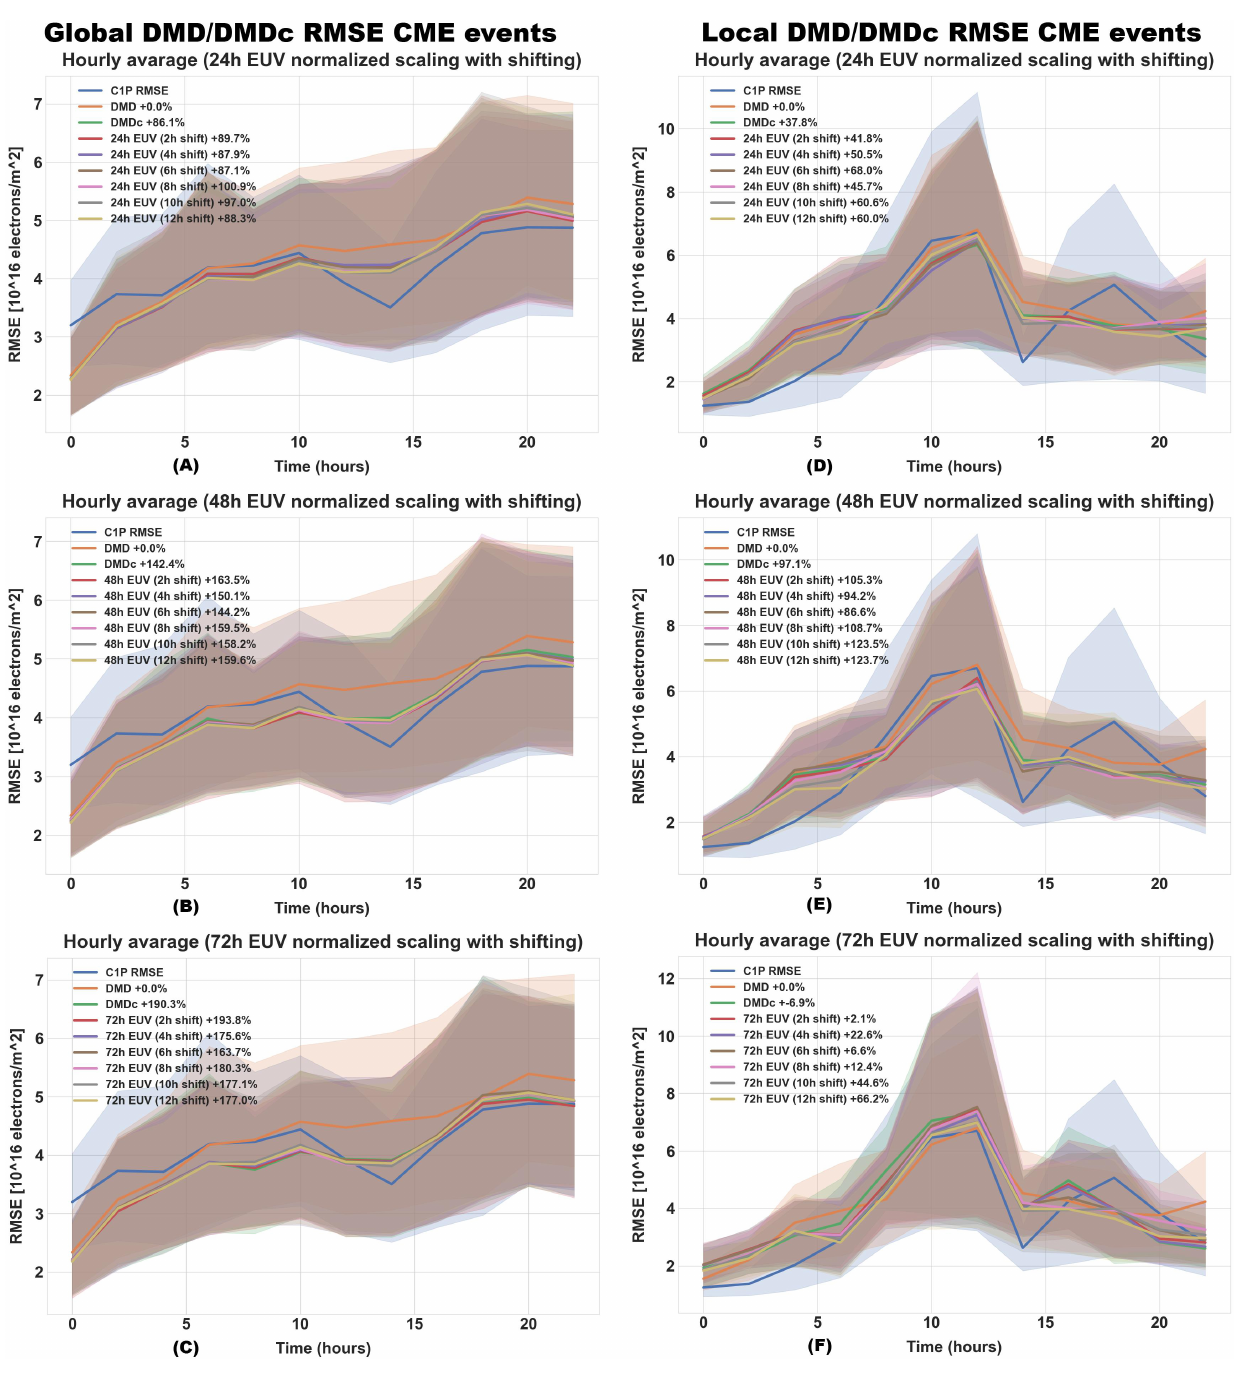
Figure 6. RMSE evaluation plot of the DMD, DMDc, and C1P predictions with 2-h candidate. On the left side, sub-figure group ( A – C ) present the global vTEC RMSE for the CME case studies with length parameters: 24, 48, and 72, respectively. On the right side, sub-figure group ( D – F ) present the local RMSE for the CME case studies with length parameters: 24, 48, and 72, respectively. All the sub-figures present the examined shift parameters of the control input signal and its improvement over the DMD model. Note that the DMDc has a zero shift